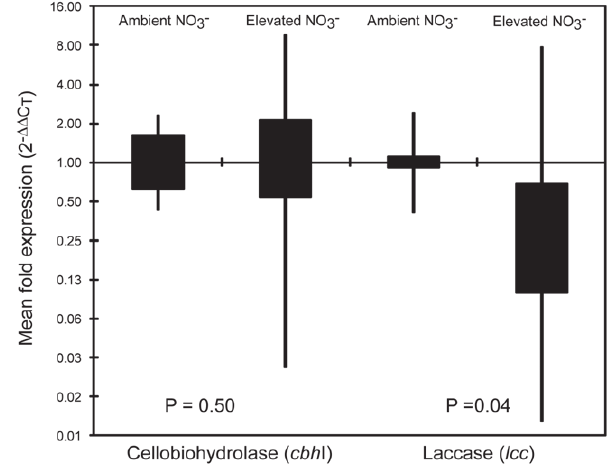
Figure 1. Relative expression of fungal cbhI and lcc genes in the forest floor of northern hardwood forests under ambient or elevated levels of N deposition. Boxes define the interquartile range, whiskers mark the minimum and maximum observations; relative expression (Y-axis) is log-scaled. P -values are significance of the mean difference in relative expression under ambient and elevated N deposition (Mann-Whitney U, n=21).